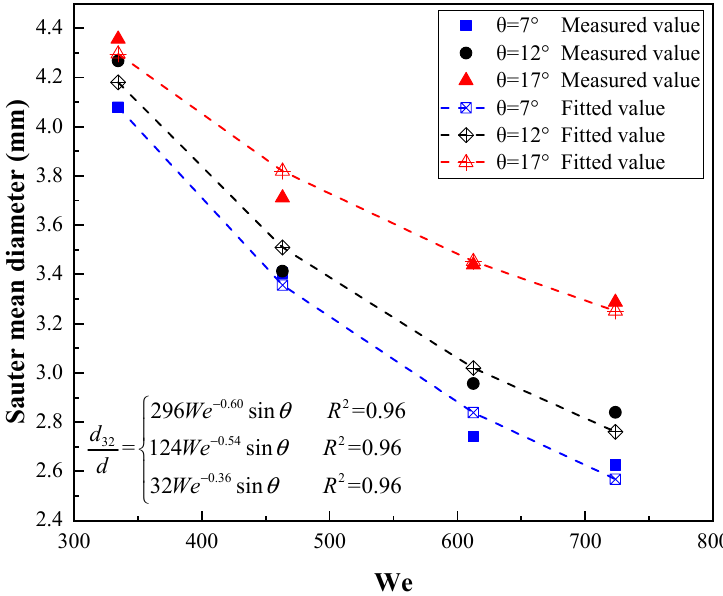
Figure 5. Variations and correlations of d 32 with Weber number.